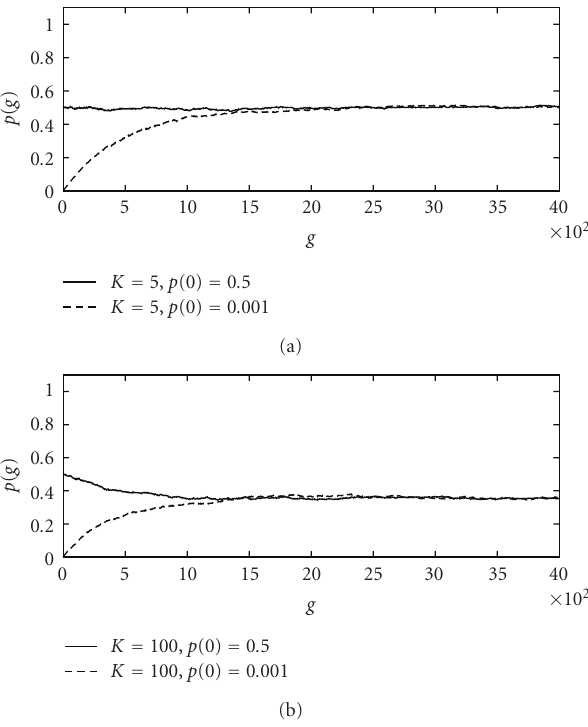
Figure 10: Transient behavior (asynchronous system, scale-free network with m = 2).